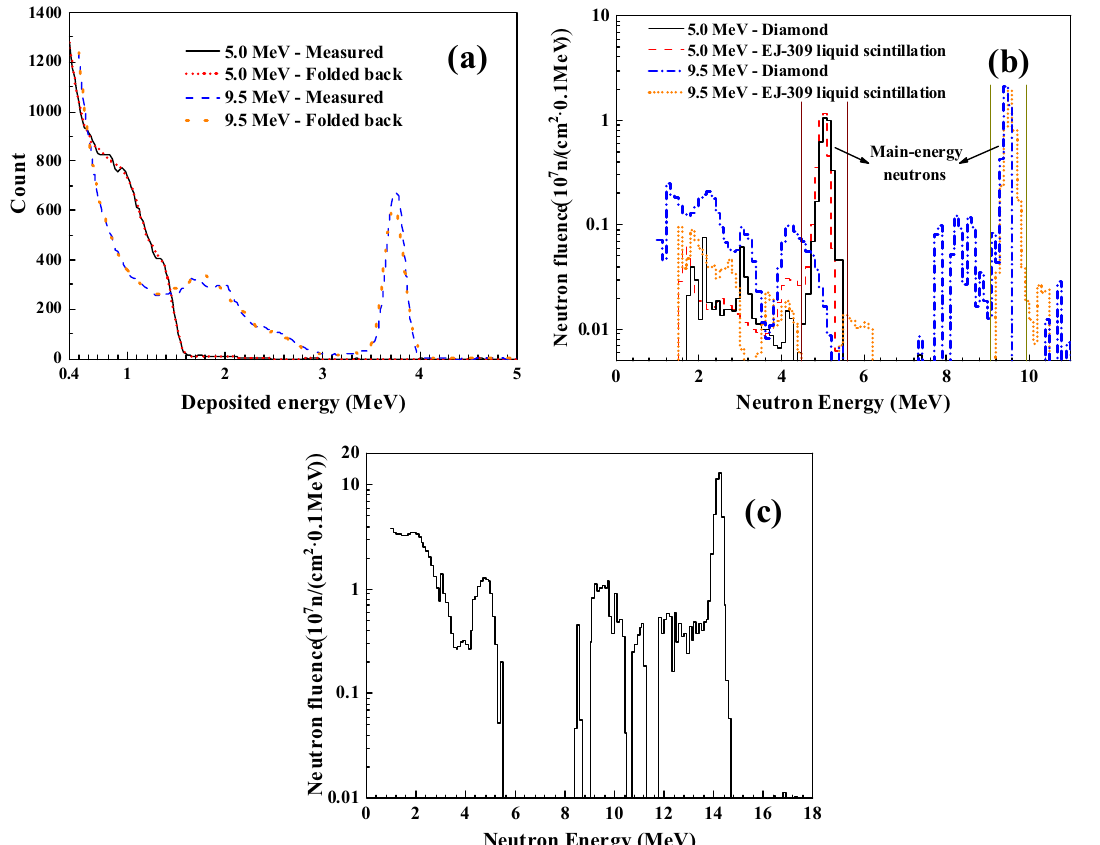
Figure 4. ( a ) The measured pulse height spectra and the folded back pulse height spectra in unfolding with the neutron energies of 5.0 MeV and 9.5 MeV for the d–d neutron sources. ( b ) The neutron energy spectra with absolute fluence measured using the diamond detector compared with those measured using the EJ-309 liquid scintillator together with the 238 U fission chamber for 5.0 MeV and 9.5 MeV neutrons from the d–d neutron sources. ( c ) The neutron energy spectrum with absolute fluence measured with the diamond detector for the d–t neutron source. Main-energy neutron fluence at the diamond position The proportion of the low- (n/cm 2 ) energy Deuteron energy (MeV) Main energy of neutrons (MeV)